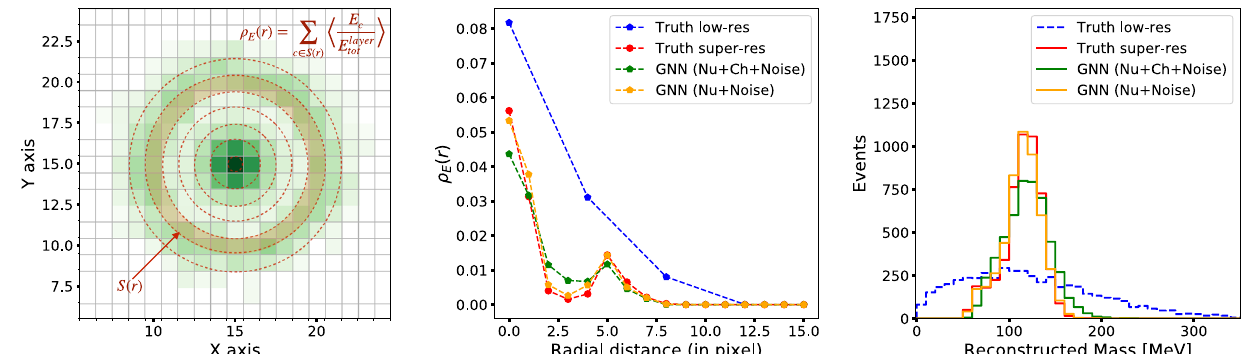
Fig. 9 (left) Average cell truth neutral energy normalised to the total energy in the second layer of the HG calorimeter, where calorimeter images have been systematically centred on the highest energy cell. From this distribution the average energy profile as a function of radial distance ρ E ( r ) is computed (as displayed in the left panel) from this 2-D distribution in rings (of surface S ( r ) ) with a width of one cell (mid- dle). (right) Calibrated reconstructed mass distribution from the neutral energy calorimeter in the LG case in blue, the truth HG case in red and the super resolution predicted HG image in green and orange. The